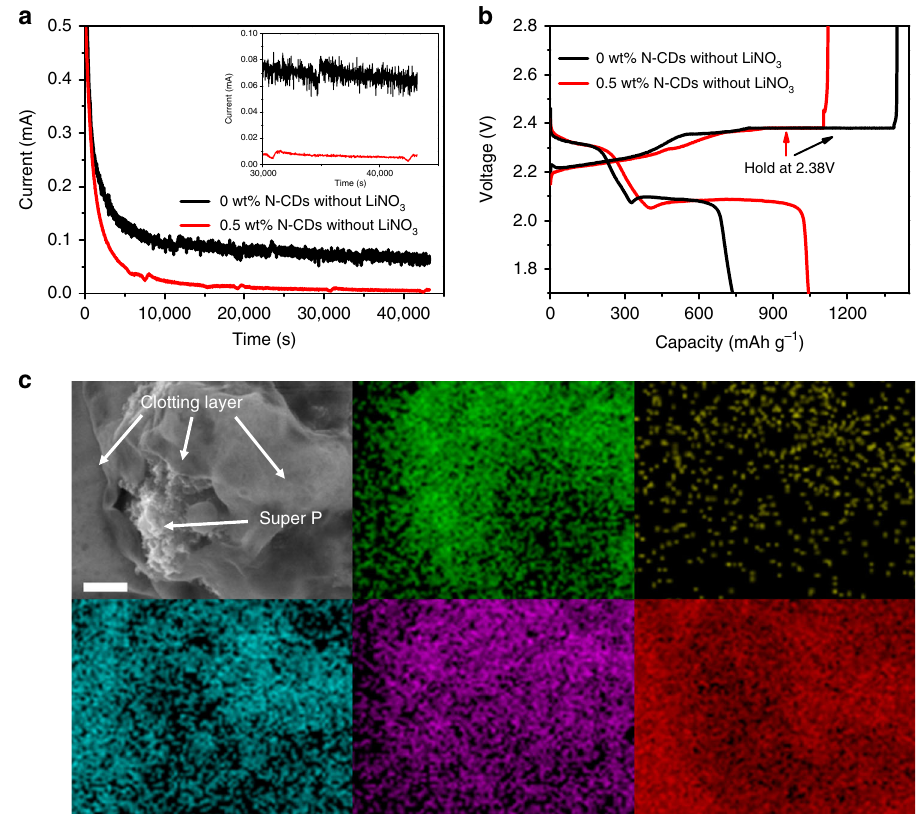
Fig. 3 Investigation of the clotting function of N-CDs for LiPS in a 2032 coin cell. a , b Shuttle current measurement and discharge/charge curves of the coin cells with 0 and 0.5 wt% N-CDs and without LiNO 3 additive. The shuttle current measurement was held at 2.38 V for 43,200 s in the cycling process at 0.2 C. c SEM image and corresponding EDS elemental mapping of the sulfur cathode with 0.5 wt% N-CDs at a discharge voltage of 2.1 V. Green is for C, yellow is for N, blue is for O, purple is for F and red is for S. Scale bar: 1 μ